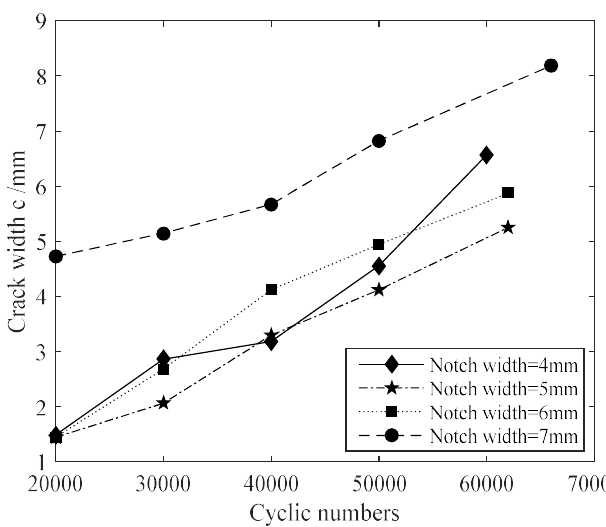
Figure 23. Variation of crack width with cyclic numbers.